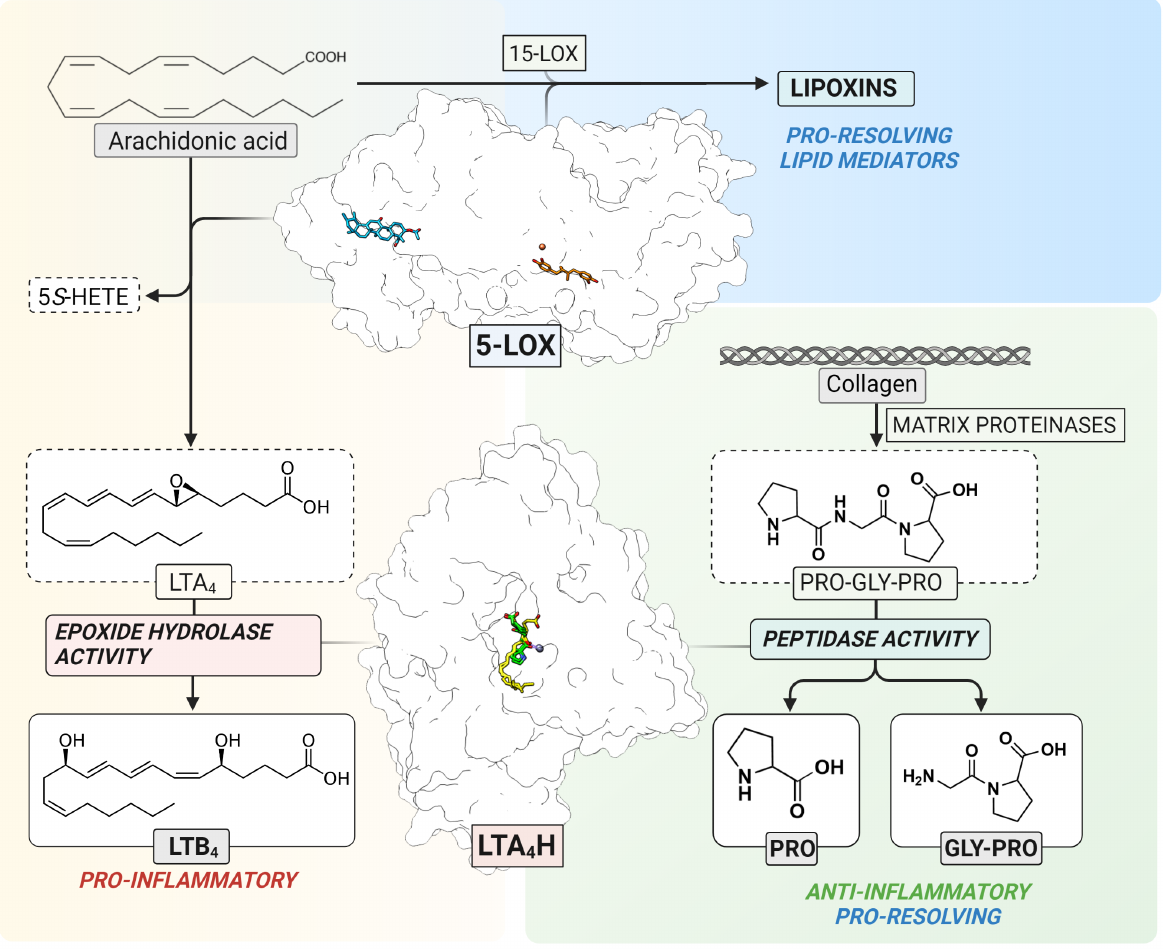
Figure 1. The 5-LOX pathway. 5-LOX catalyzes the oxygenation of arachidonic acid to 5 S -HETE and the LTA 4 epoxide as the substrate for LTA 4 H. In parallel, 5-LOX contributes to the formation of lipoxins in cooperation with 15-LOX ( top ). LTA 4 H catalyzes the conversion of unstable LTA 4 to LTB 4 ( left ) or the cleavage of a neutrophil chemoattractant, Pro-Gly-Pro ( right ). The structure of 5-LOX has been elucidated with two inhibitors, NDGA (orange) in the catalytic center containing non-heme iron (red) and AKBA (blue) inside an allosteric pocket between the β -barrel and catalytic domain, respectively. The structure of LTA 4 H contains overlapping binding sites for LTA 4 (yellow) and Pro-Gly-Pro (green) which interact with the catalytic zinc (purple).